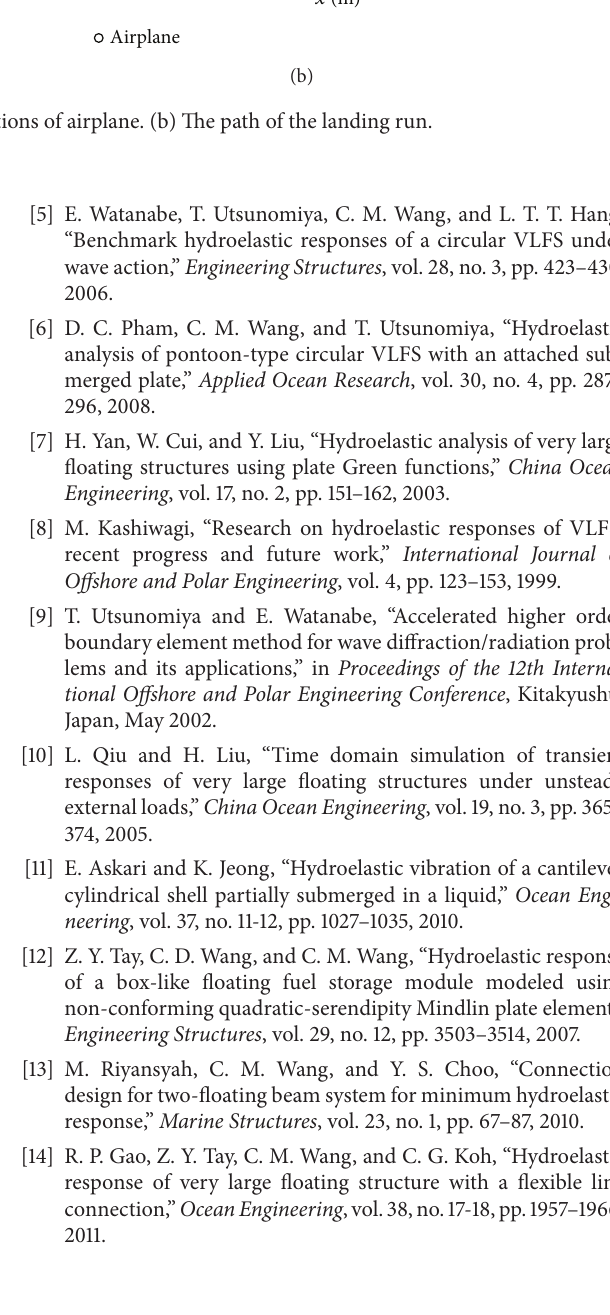
Figure 17: (a) The vertical displacement of locations of airplane. (b) The path of the landing run.